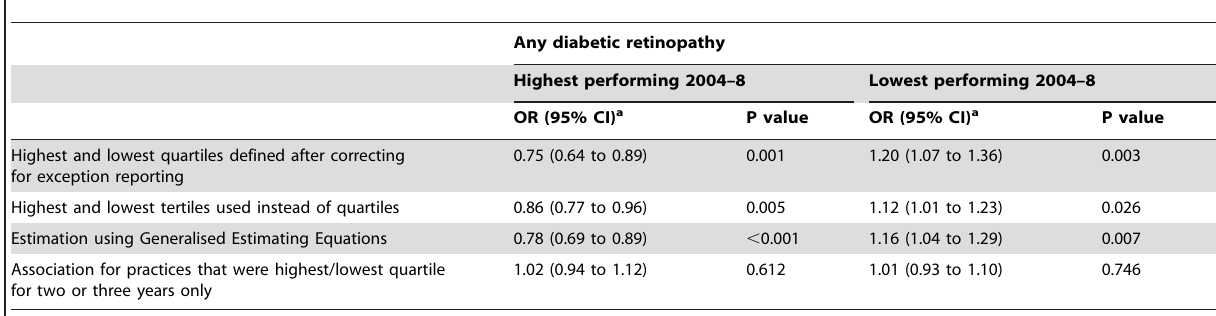
Table 3. Results of sensitivity analyses in which estimation methods and assumptions were